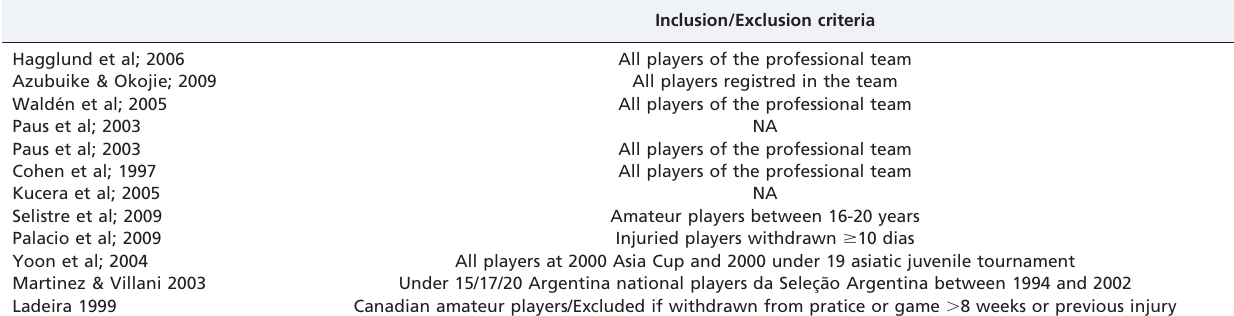
Table 4 - Inclusion and exclusion